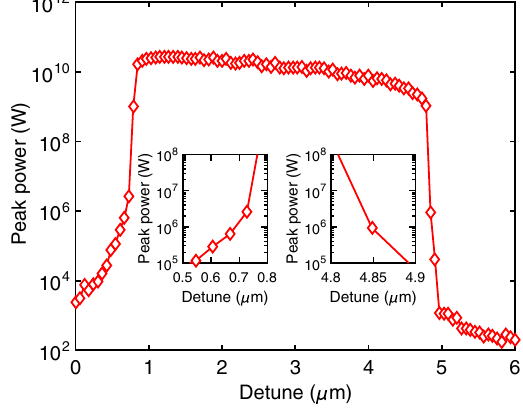
FIG. 3. The XFELO output peak power at different cavity